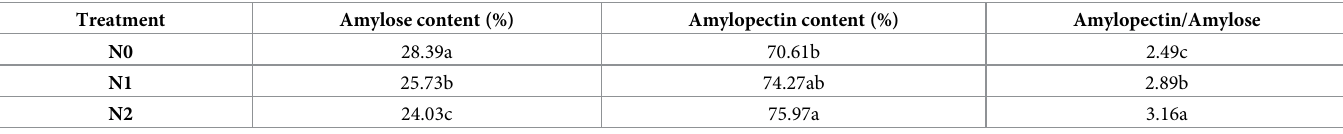
The values in the same column with different letters differ significantly (p <